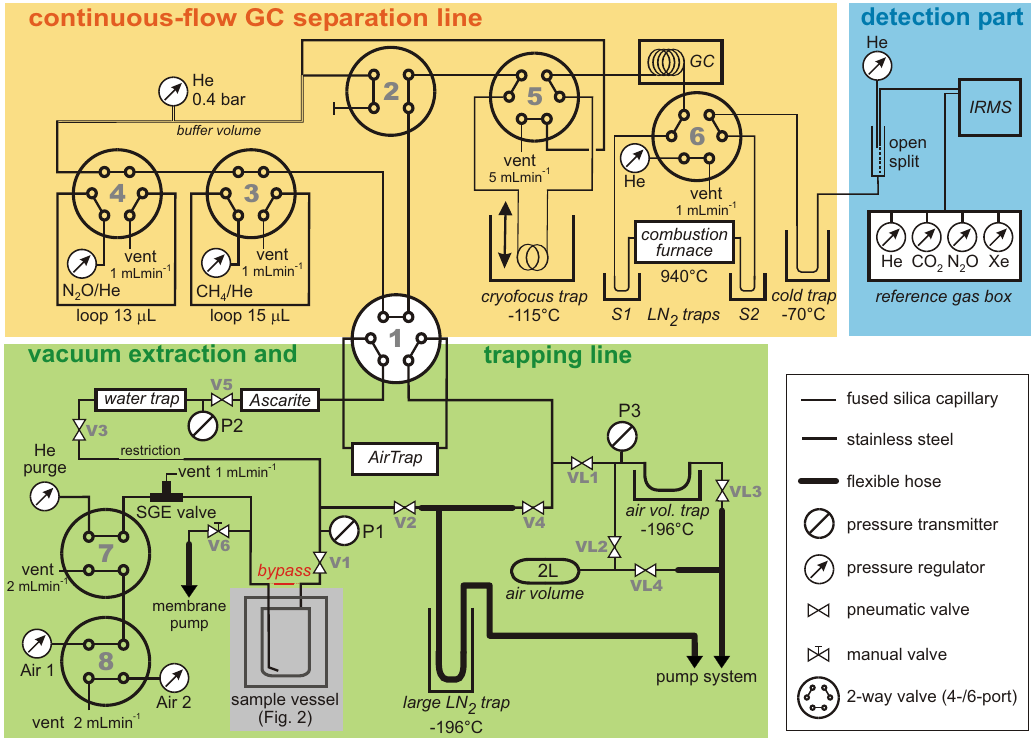
Figure 1. Custom-built analytical set-up comprising the vacuum extraction and trapping line (green), the continuous-flow line with the gas chromatograph (GC) and the combustion furnace (orange), and the detection part (blue). The sample vessel (shaded grey) is sketched in detail in Fig. 2. Note that throughout the paper the 2-way valves (4- / 6-port) are referred to as e.g. valve 1, while the Swagelock on/off